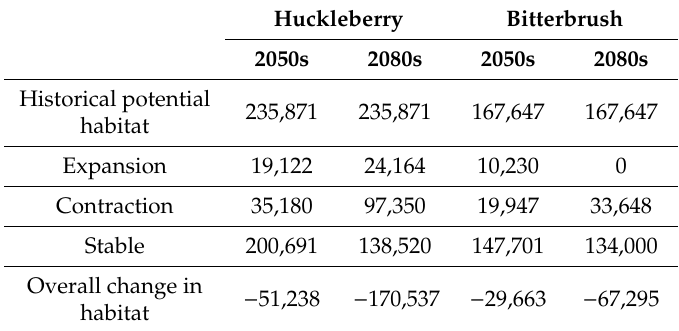
Table 2. Area (square kilometers) of potential expansion, contraction, and areas that may remain stable for huckleberry and bitterbrush habitat for the study